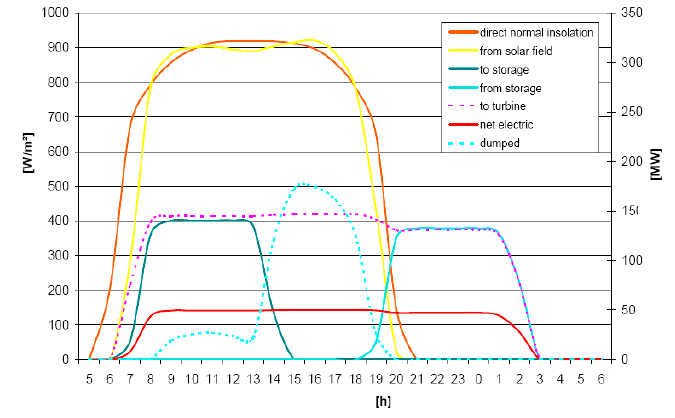
Figure 4. Hourly distribution of solar radiation during a typical day.